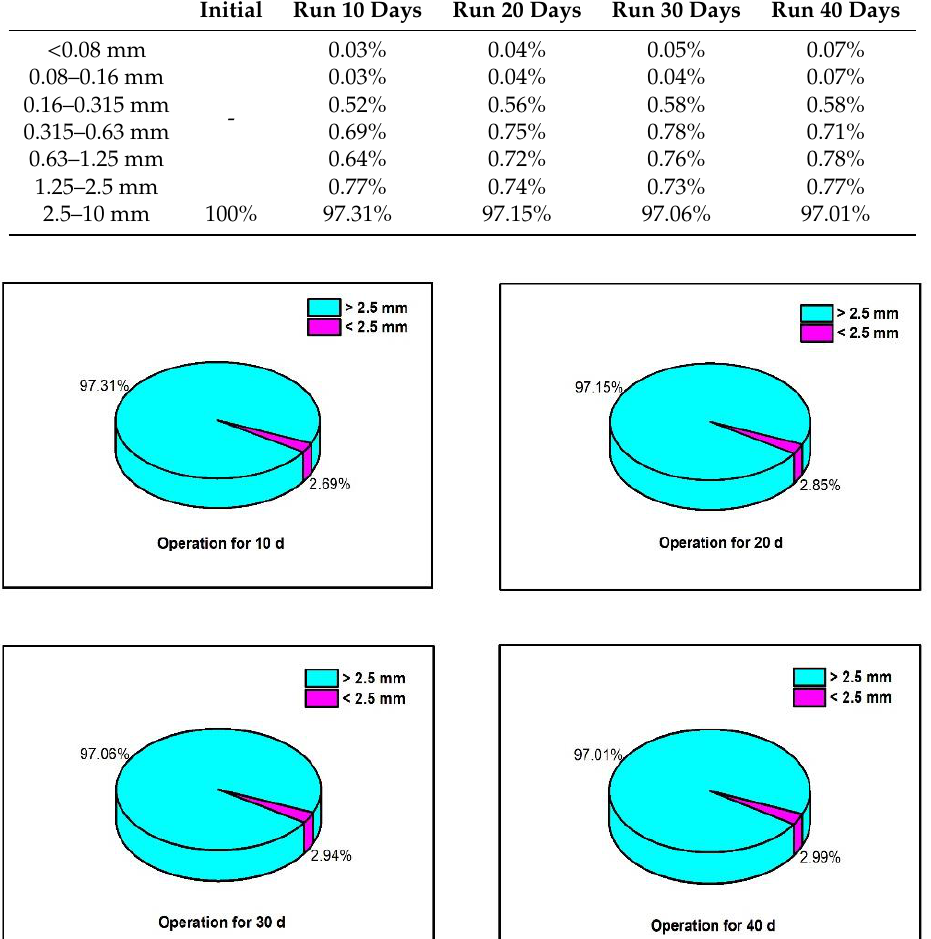
Table 6. Change in particle size distribution of drainage layer filler during operation.